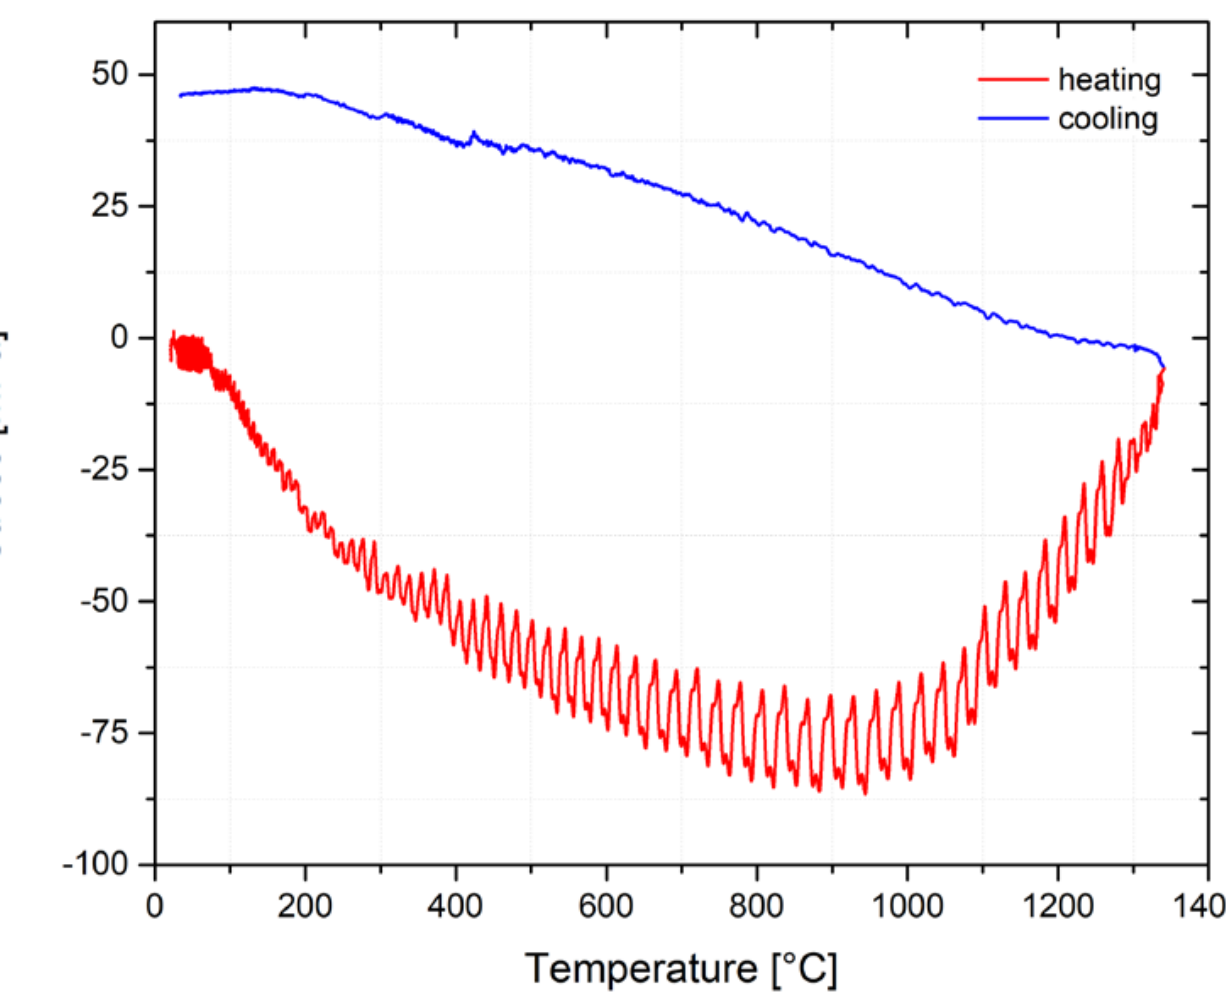
Figure 11. Stress vs. temperature in the sample; temperature cycle of 1386 °C.